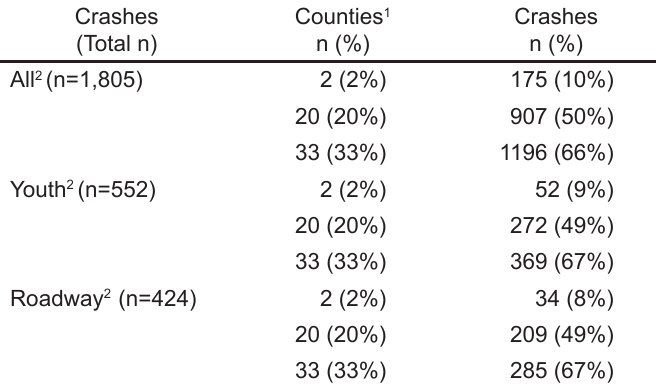
Table 4. Proportion of crashes in the state as a function of the counties with the highest number of crashes for each of the indicated crash categories in the Iowa Off-Road Vehicle Crash and Injury Database from January 1, 2002 through December 31,